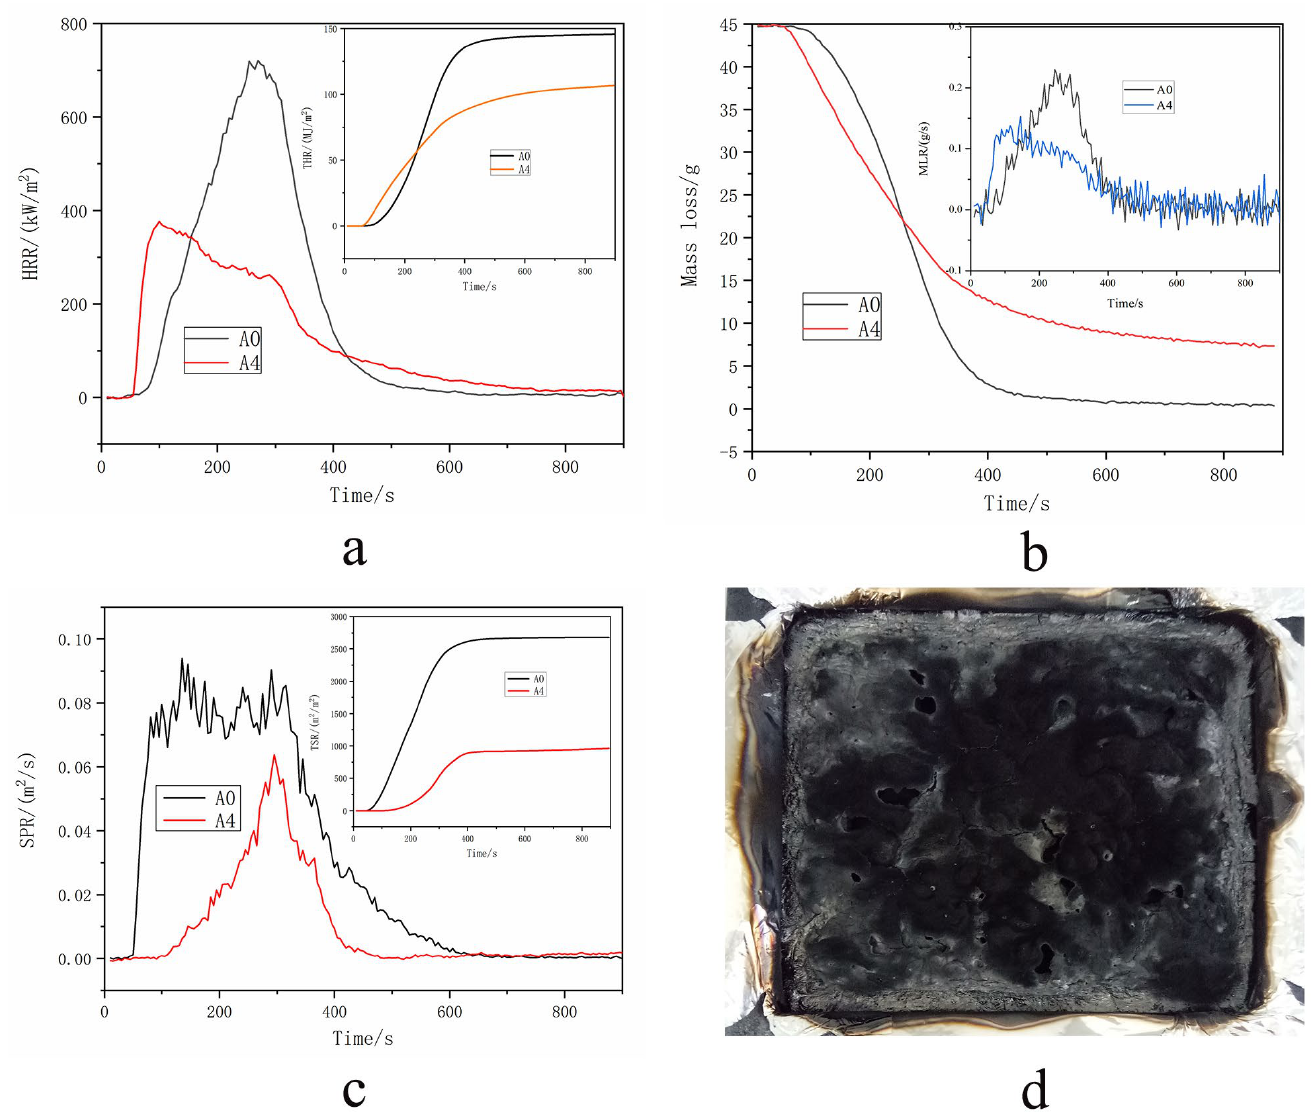
Figure 4. The cone curves of FR–PA66. ( a ) The HRR and THR curves of FR-PA66, ( b ) the MLR and ML curves of FR–PA66, ( c ) the SPR and TSR curves of FR–PA66, and ( d ) a picture of FR–PA66 after the cone test.